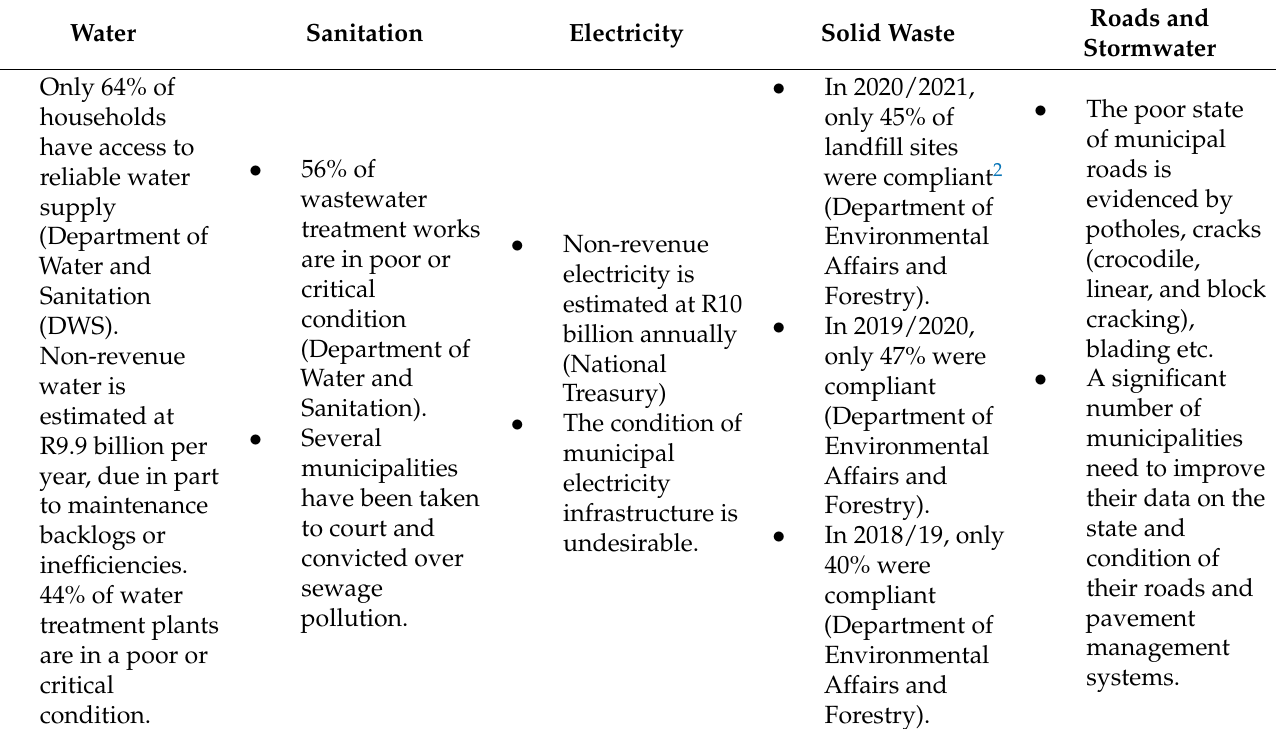
Table 2. Municipal infrastructure reliability by service type in South Africa.